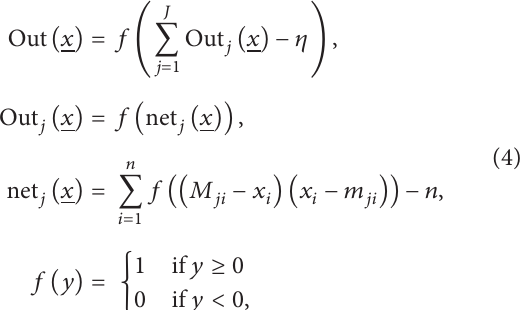
LDP 70 , LDP 76 , LDP 98 , LDP 100 , LDP 137 , LDP 140 , LDP 145 ,